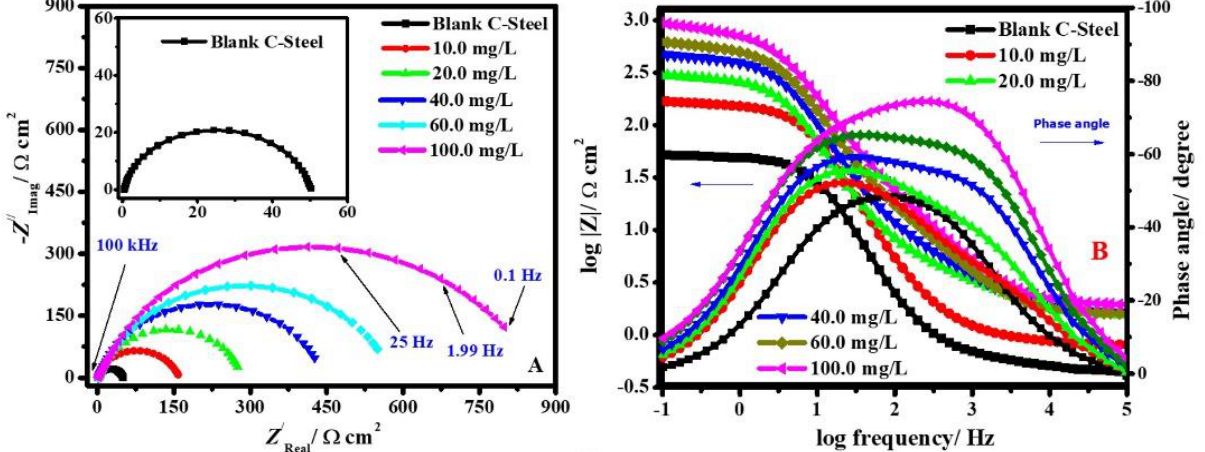
Figure 7. Nyquist ( A ) and Bode modules, ( B ) graphs of CS-alloy corrosion in the molar HCl with 3.5% NaCl and after the addition of diverse concentrations of ZnTiO@PANi at 298 K.